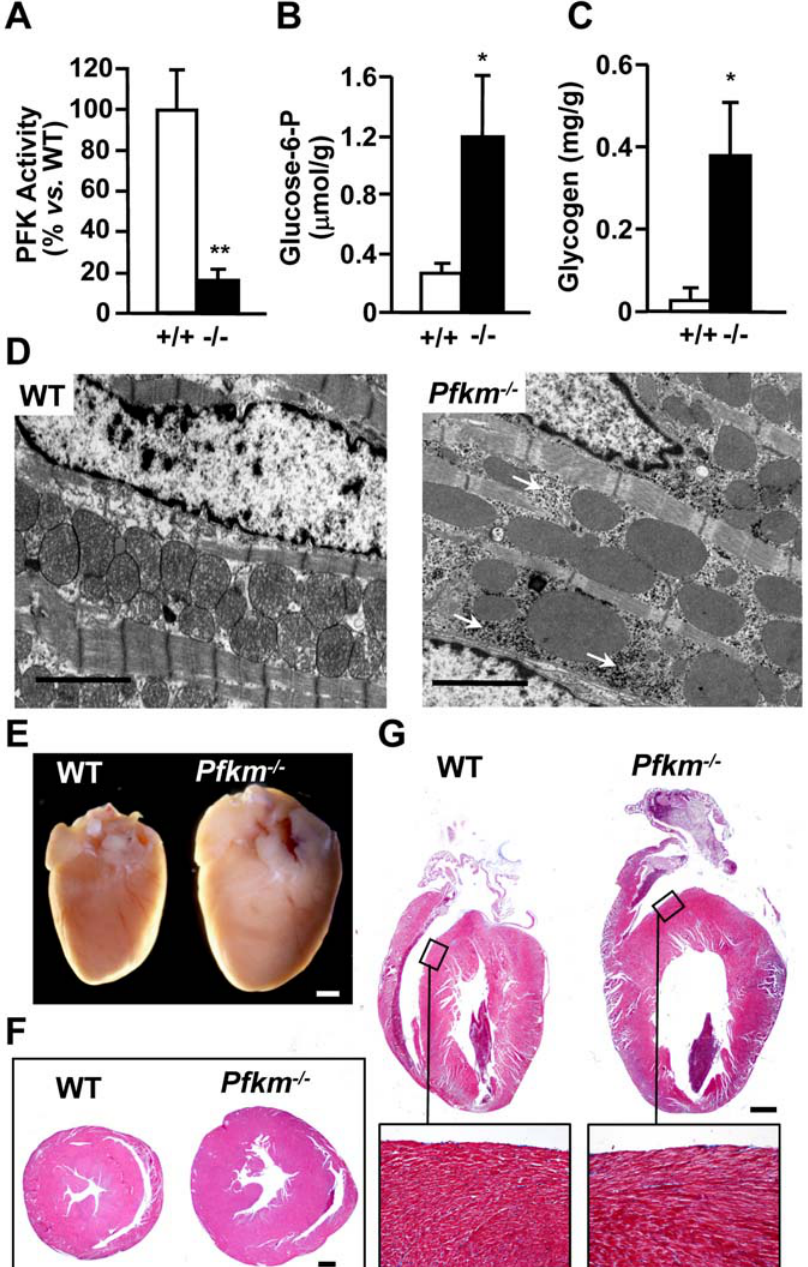
Figure 5. Pfkm 2 / 2 mice show altered heart glucose metabolism and develop cardiomegaly with age. (A) PFK activity was determined in heart extracts. Basal PFK activity in wild-type mice was 27.4 6 5.4 U/g tissue. (B,C) Glucose-6-phosphate (B) and glycogen concentrations (C) were determined in heart perchloric extracts from 2-month-old wild-type ( + / + ) and Pfkm 2 / 2 ( 2 / 2 ) mice. Results are mean 6 SEM of five mice per group. * P , 0.05, ** P , 0.01 vs. wild-type. (D) Transmission electron microscopic analysis of cardiac muscle. Arrows show glycogen storage. Scale bar 2 m m. (E,F) One-year-old Pfkm 2 / 2 mice develop cardiac hypertrophy, evidenced by hematoxilin-eosin staining of heart sections (scale bar 1 mm) (E) and cardiomegaly (F). (G) Longitudinal sections of heart from 3-month-old mice stained with Masson trichromic reagent (scale bar 1 mm). Inset shows septum sections (scale bar 50 m m).